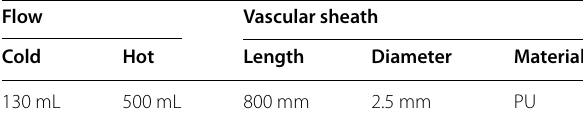
Figure 4 Diagram of the structure of the downstream simulation system: (1) Water tank, (2) Hot and cold mixing, (3) Temperature sensor, (4) Cold water tank, (5) Water pump, (6) Reducer, (7) Analog